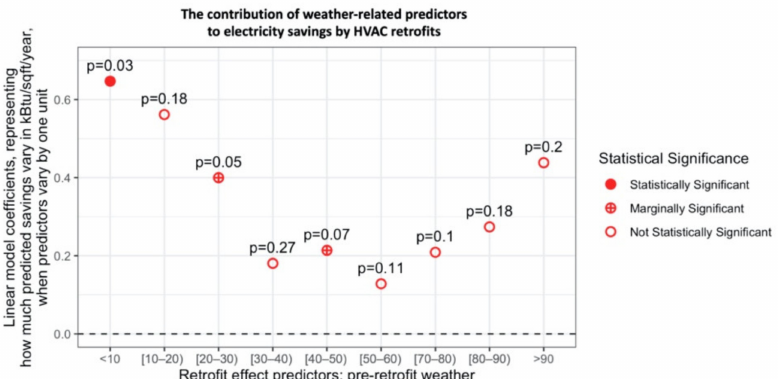
Figure 17. The contribution of weather predictors to total electricity savings by HVAC retrofits.